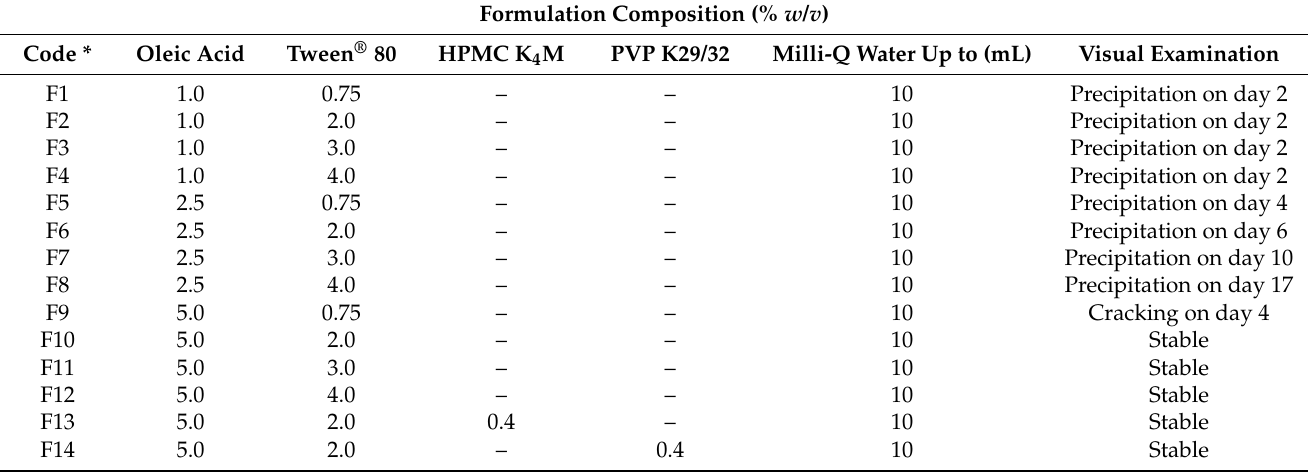
Table 2. Composition of different moxifloxacin-loaded nanoemulsions and nanoemulsions with mucoadhesive agent